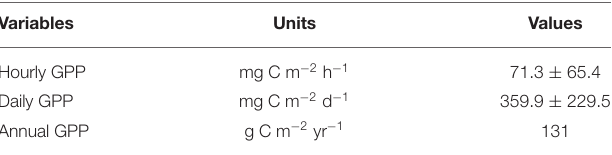
TABLE 1 | Simulated GPP estimates (MARS-3D season run) at the sampling site in